Question: In a single sentence, describe what this figure presents.
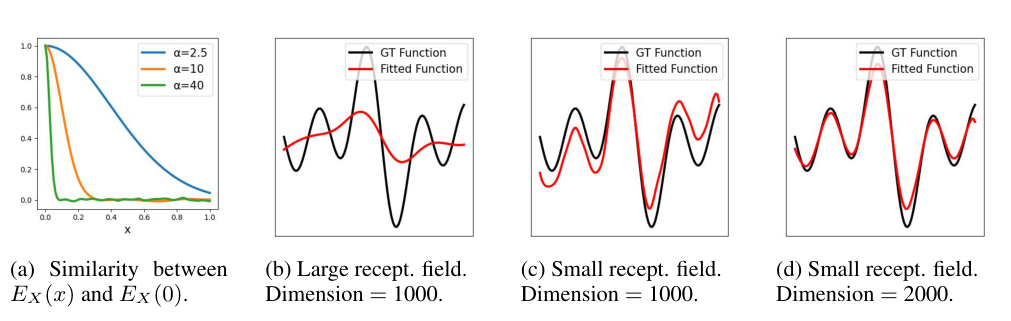
Answer: (a): How α and β in equation 6 affects the receptive field of HDFE. (b)-(d): Functions can be reconstructed accurately given a suitable receptive field and encoding dimension. To capture the high-frequency component of the function, a small receptive field and a high dimension are required.